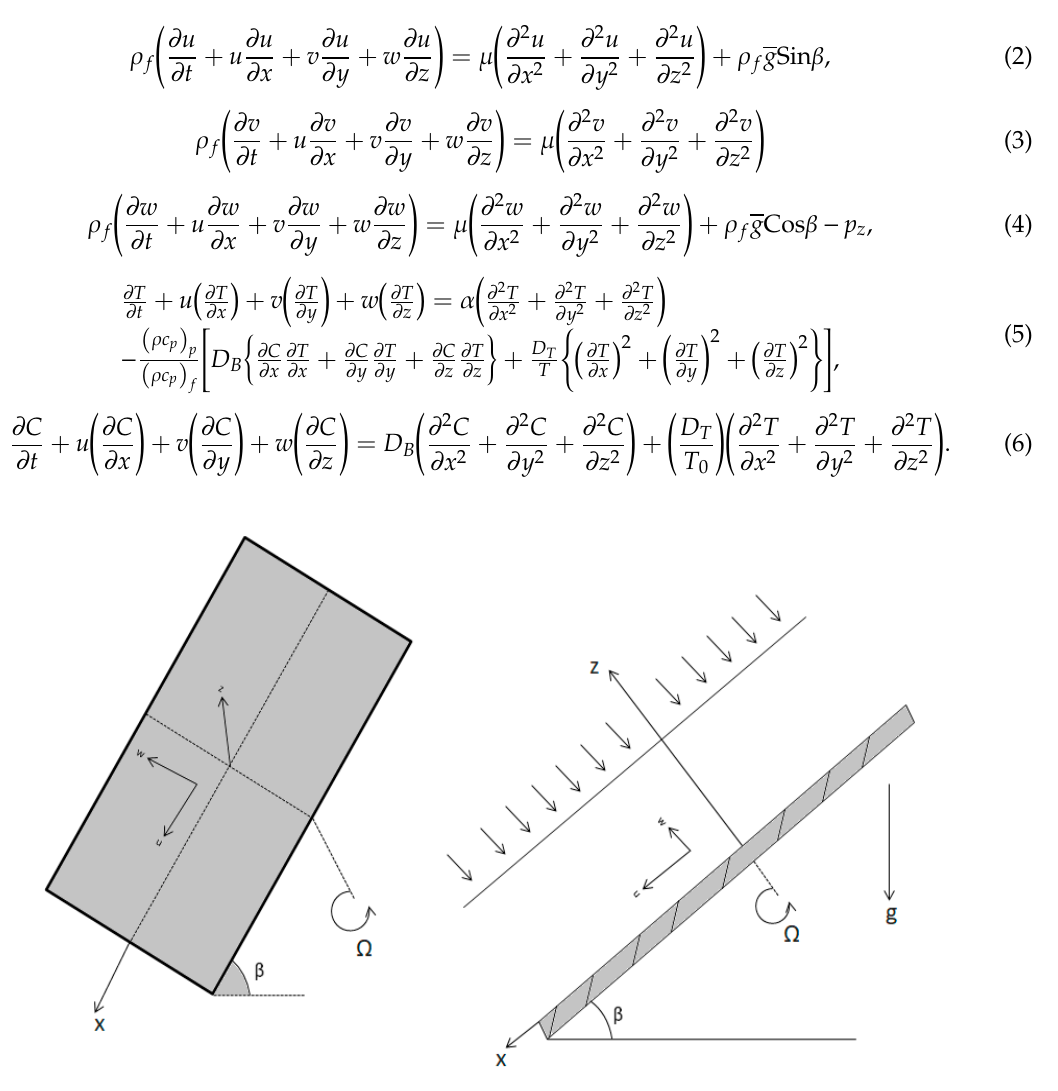
Figure 1. Diagram of the physical problem.